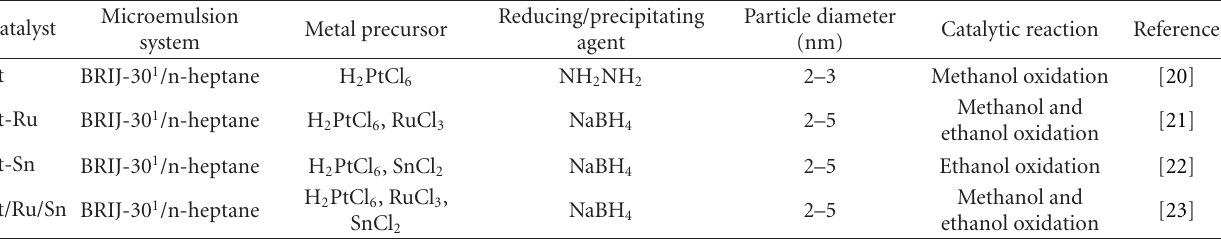
Table 1: Survey of recent publications on metal/metal oxide particles from microemulsions deposited onto BDD thin film electrodes with applications in fuel